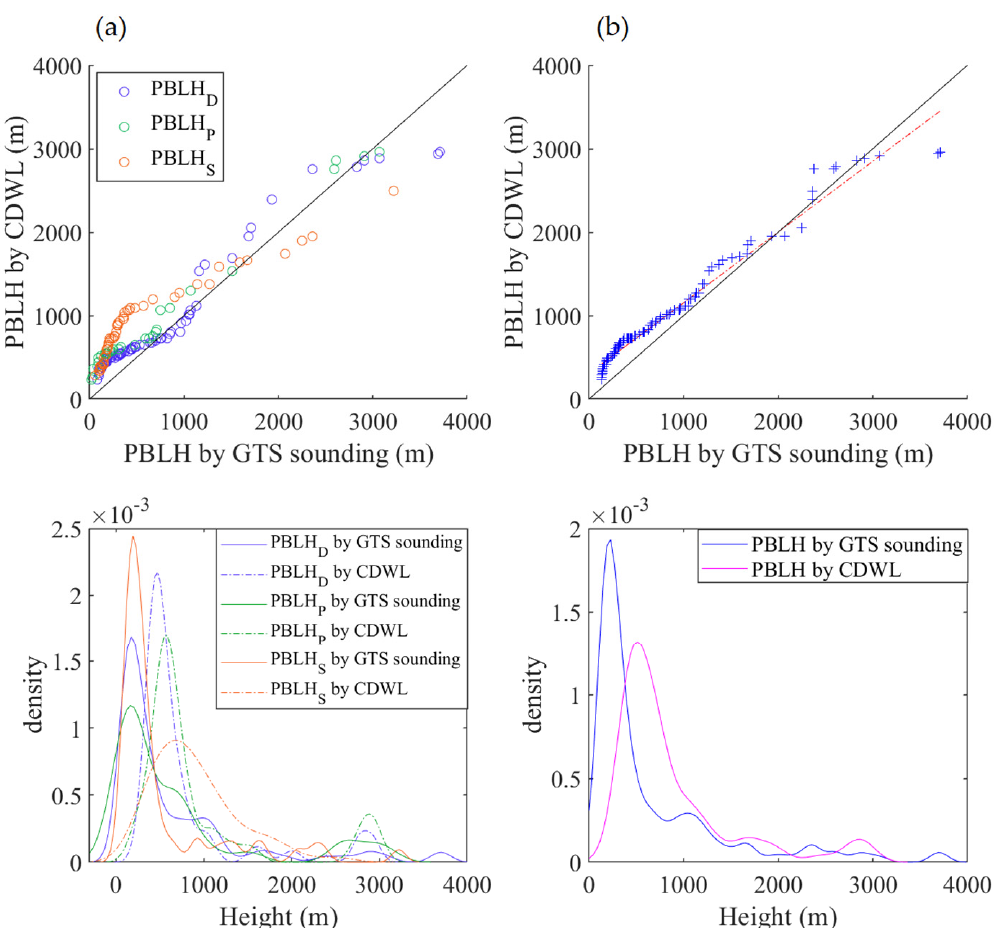
Figure 6. Quantile–quantile plot and probability density distribution of the PBLH inversions of CDWL and GTS soundings by ( a ) weather type and ( b ) overall sample for dust (D), precipitation (P), and clear skies (S).